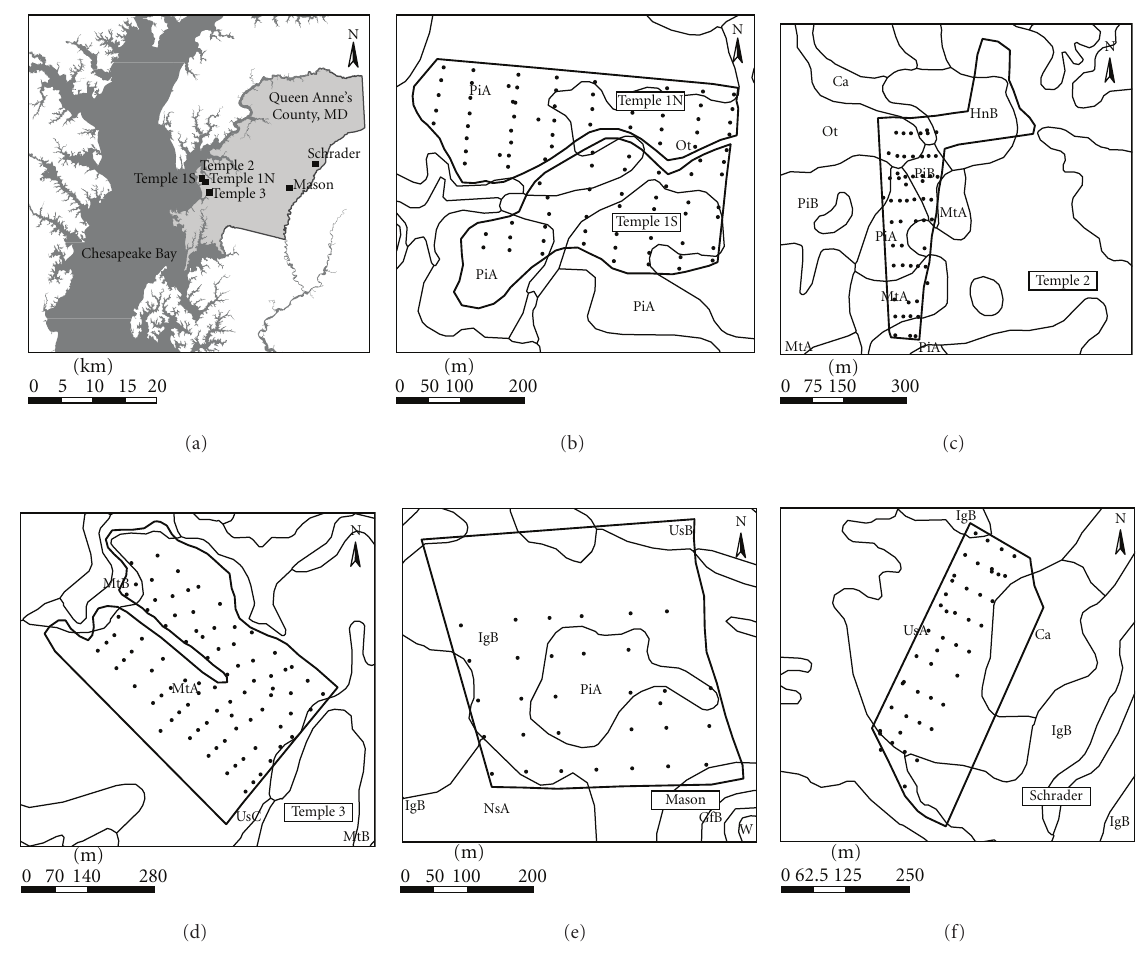
Figure 1: Field sites with soil sampling locations (black points) and SSURGO soil boundaries. See Materials and Methods for soil type